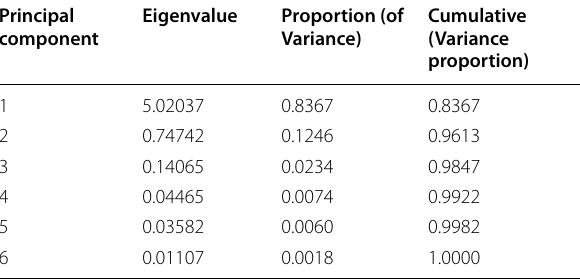
Table 3 Principal components analysis-eigenvalues.